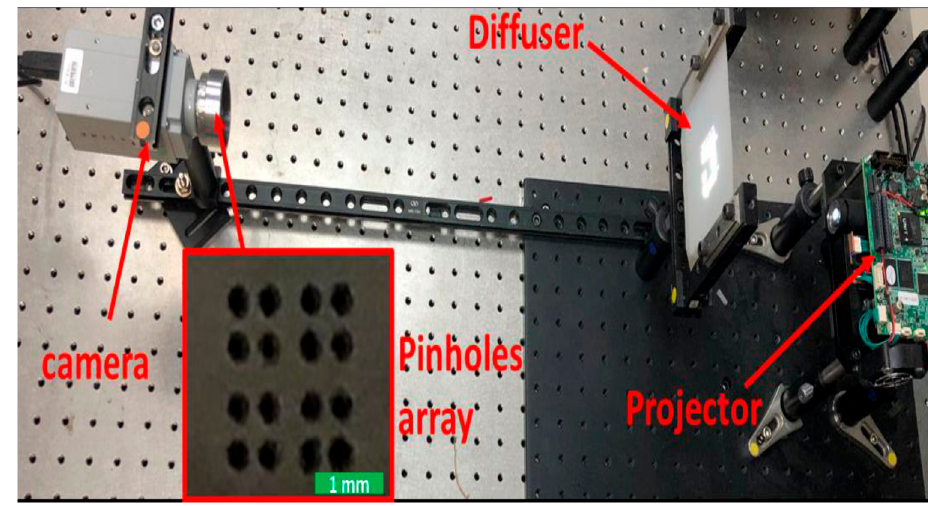
Figure 2. Experimental setup.